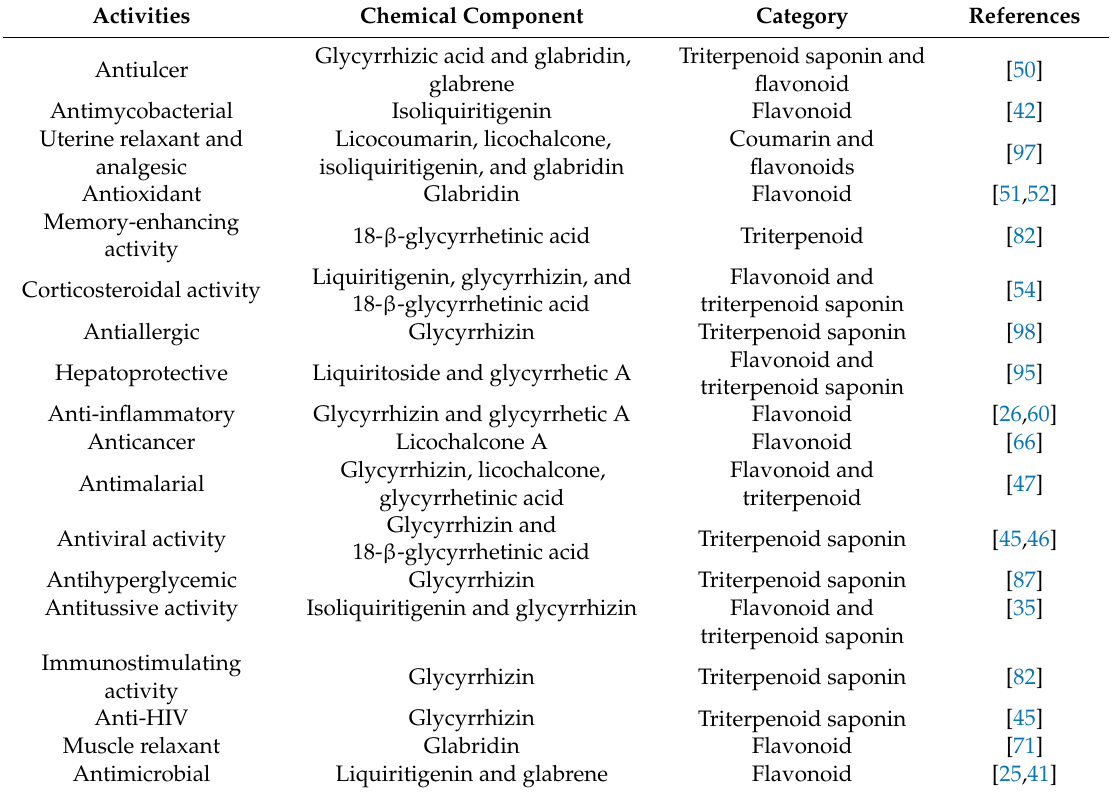
Table 3. Chemical components responsible for licorice e ffi